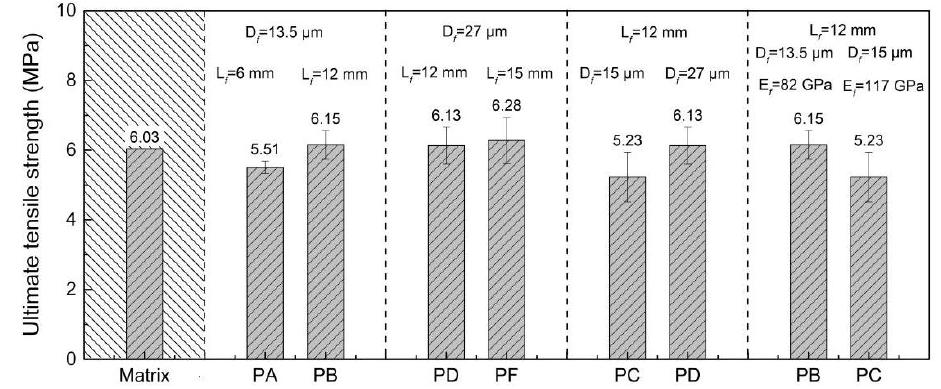
Figure 7 . Tensile strength of PE fiber-reinforced UHPC.